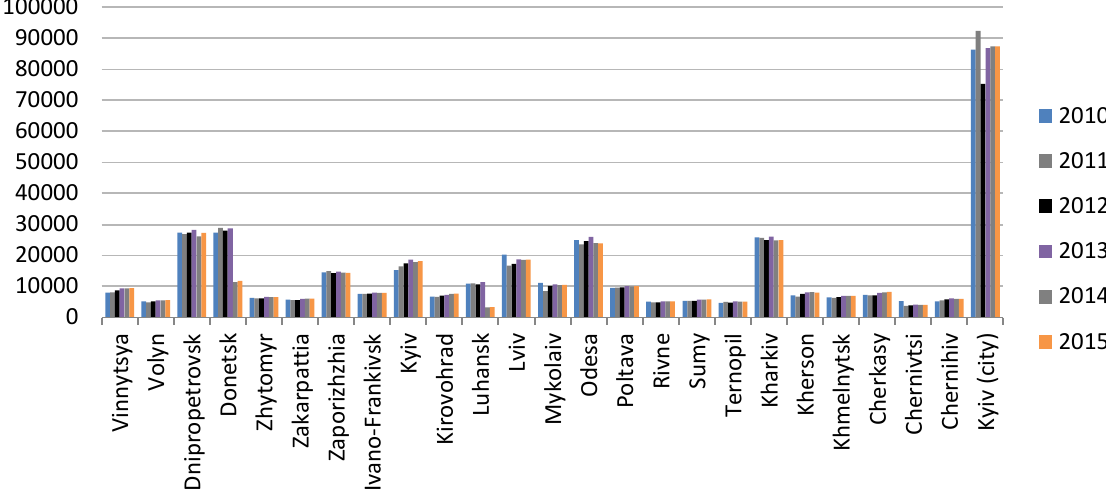
Fig. 8. The number of enterprises by region in 2010 – 2015, units (based on data of the State Statistics Service of Ukraine)